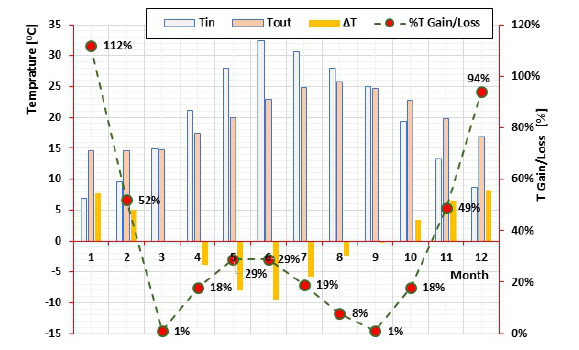
Fig. 13. Air temperature at the Inlet and outlet, and temperature difference in the fourth year each month on the left vertical axis. The relative gain/loss in temperature is shown as a percentage of the inlet tem- perature on the right vertical axis.